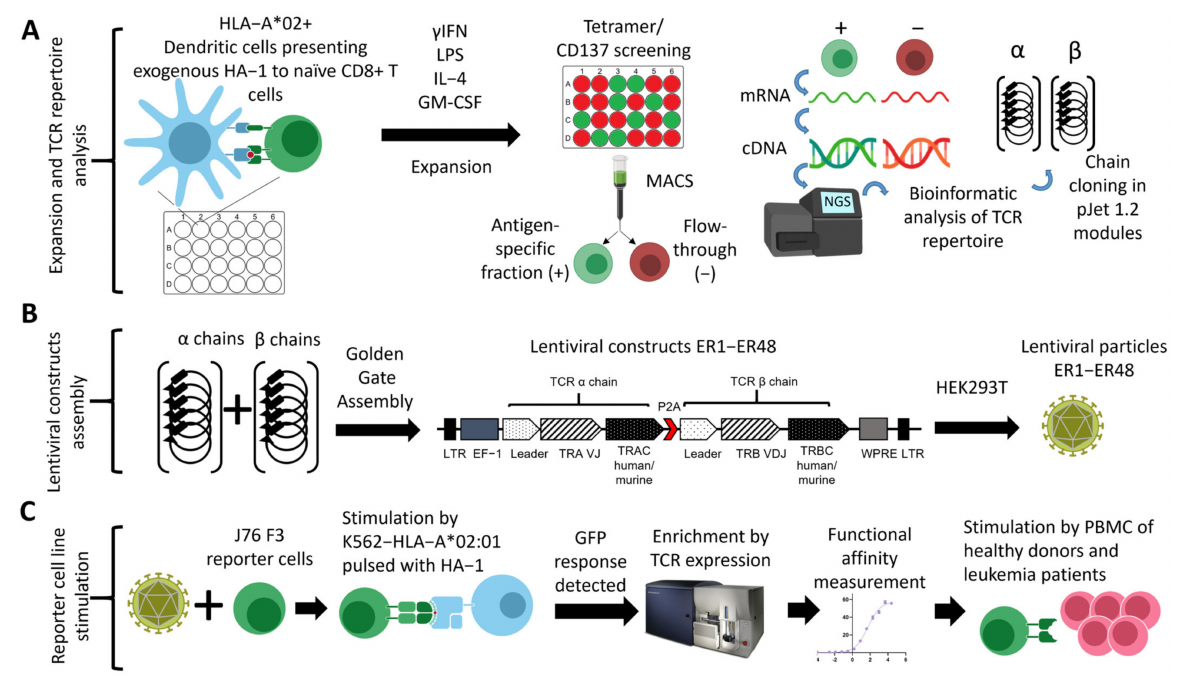
Figure 1. Schematic workflow of the study. ( A ) Naive CD8 + T cells were expanded using autologous or allogeneic dendritic cells from the HLA-A*02 + donors. Individual wells were screened for the presence of antigen-specific cells by tetramer or CD137 staining. The HA-1 − specific TCR chains were identified after sequencing and bioinformatic analysis of the TCR repertoire of tetramer/CD137 + fraction and flowthrough. Selected HA-1 − specific TCRs α and β chains were cloned into pJet 1.2 plasmids and used as the modules for the seamless cloning of lentiviral constructs. ( B ) Using a lentiviral backbone specifically designed for seamless cloning, the lentiviral constructs containing 48 TCR a/b chain combinations were assembled and used to produce lentiviral particles containing. ( C ) The reporter J76 cell lines expressing transgenic TCRs were generated; the functionality